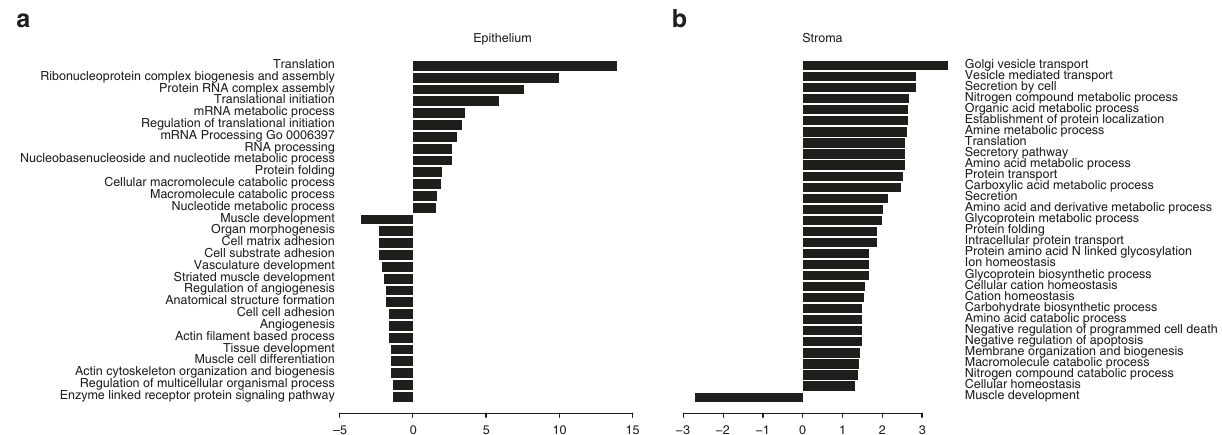
Fig. 2 GO biological processes differentially enriched between a Benign and tumor epithelium; b Benign and tumor adjacent stroma. Lengths of the bars are equal to − log10(FDR) values from the gene set analysis. Negative values indicate enrichment in benign epithelium or stroma, respectively, positive values indicate enrichment in the tumor or tumor adjacent